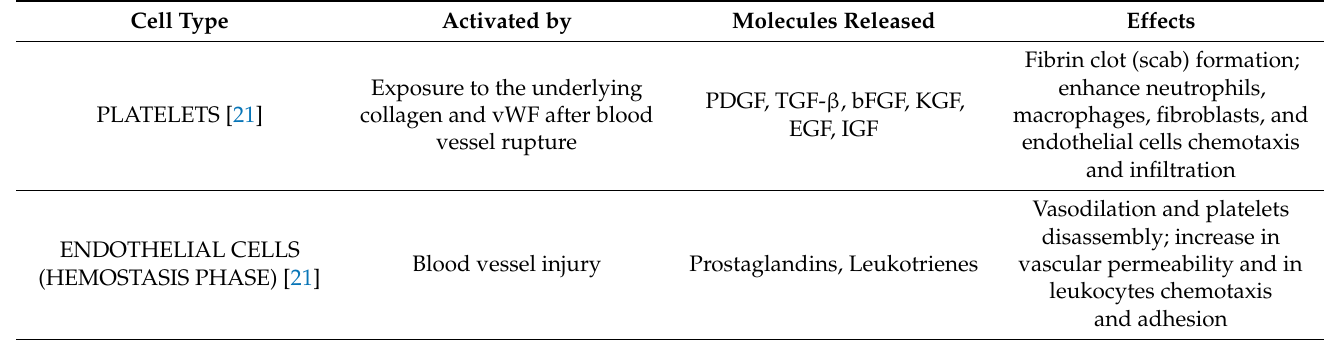
Table 1. Main cells and molecules involved in the wound healing